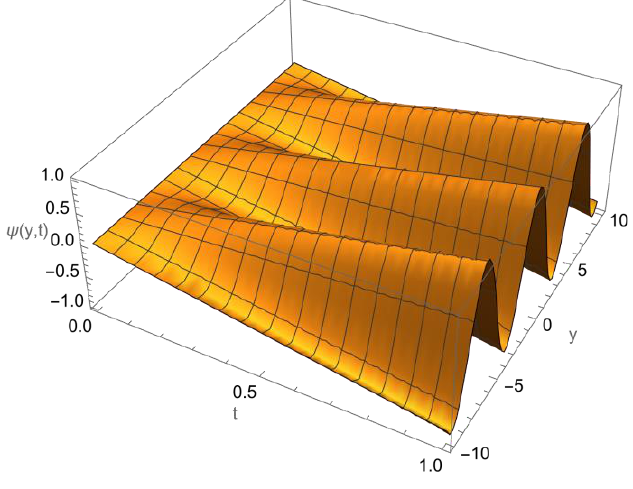
Figure 5. Exact solution ψ ( y , t ) of Example 5.